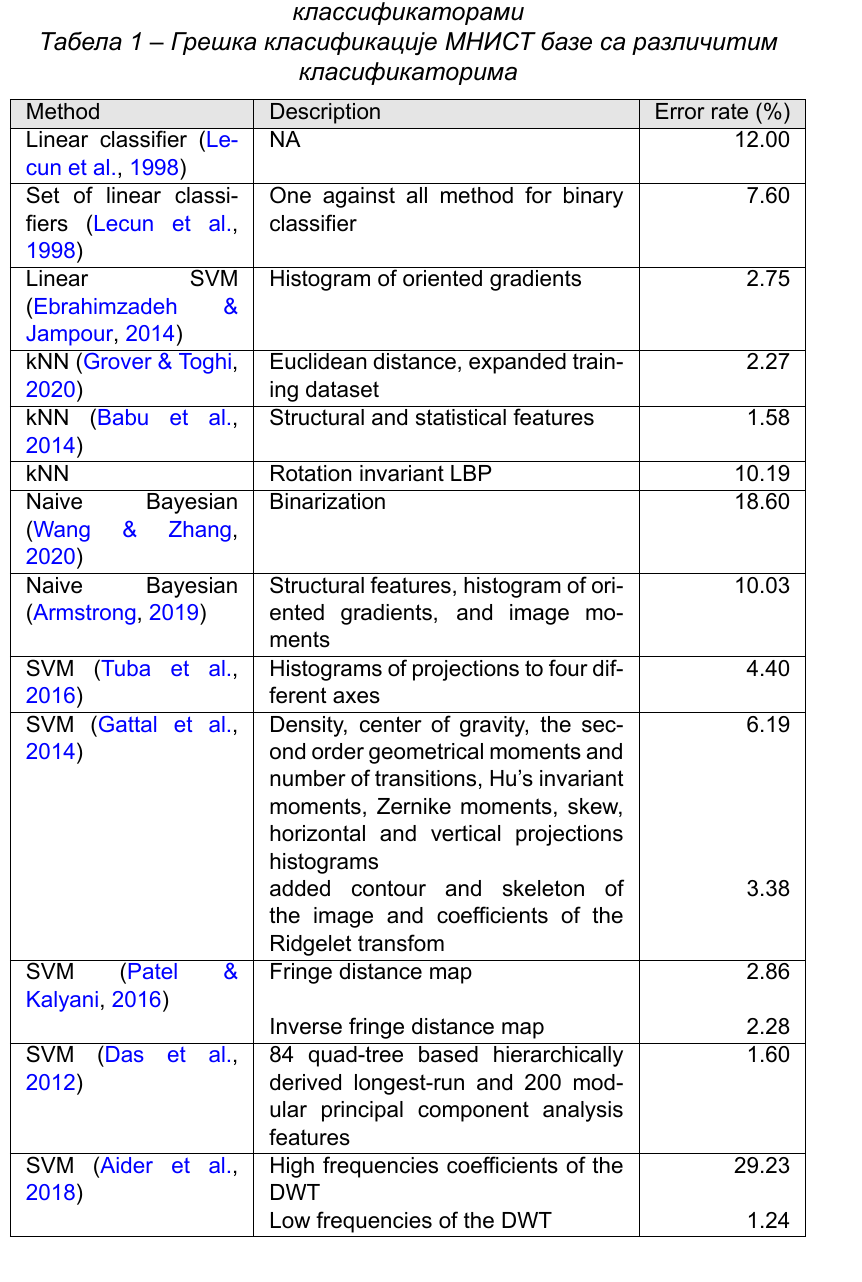
Table 1 – Classification errors for the MNIST dataset with different classifiers Таблица 1 – Ошибки классификации в наборе данных MNIST с